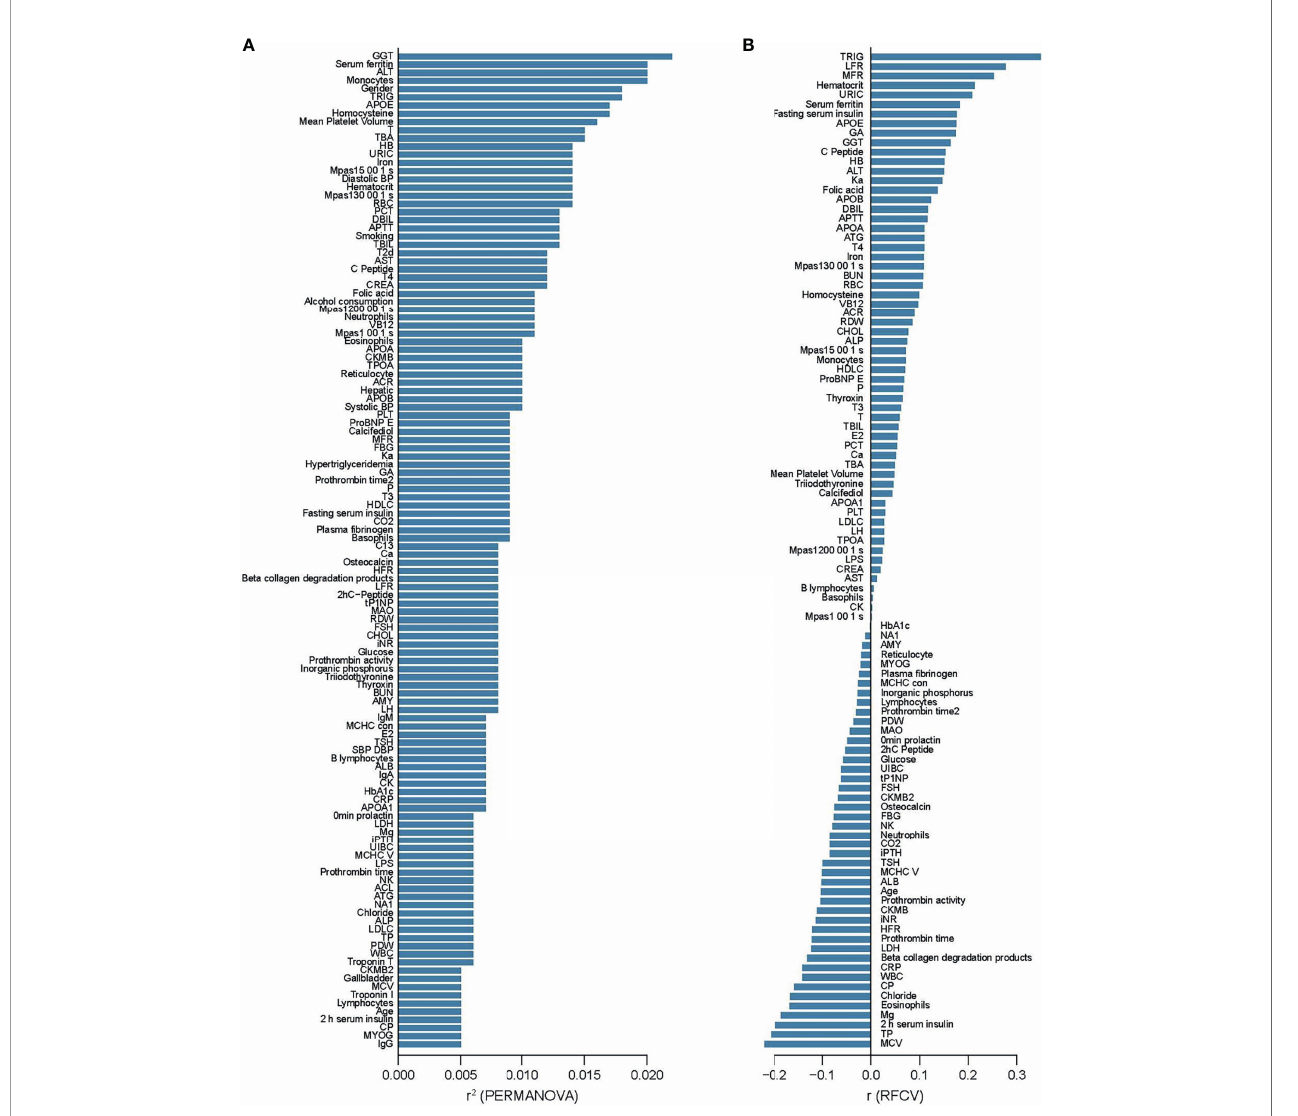
FIGURE 1 | Alterations of the gut microbiome community associated with clinical parameters. (A) Clinical parameters that showed associations with MGS composition in PERMANOVA, ranked by the effect size (r 2 ). p < 0.05, q < 0.1 (B) Prediction of clinical parameters by MGS relative abundances with random forest models, ranked by the performance (the correlation coef fi cient between predicted value and the measured value). p <